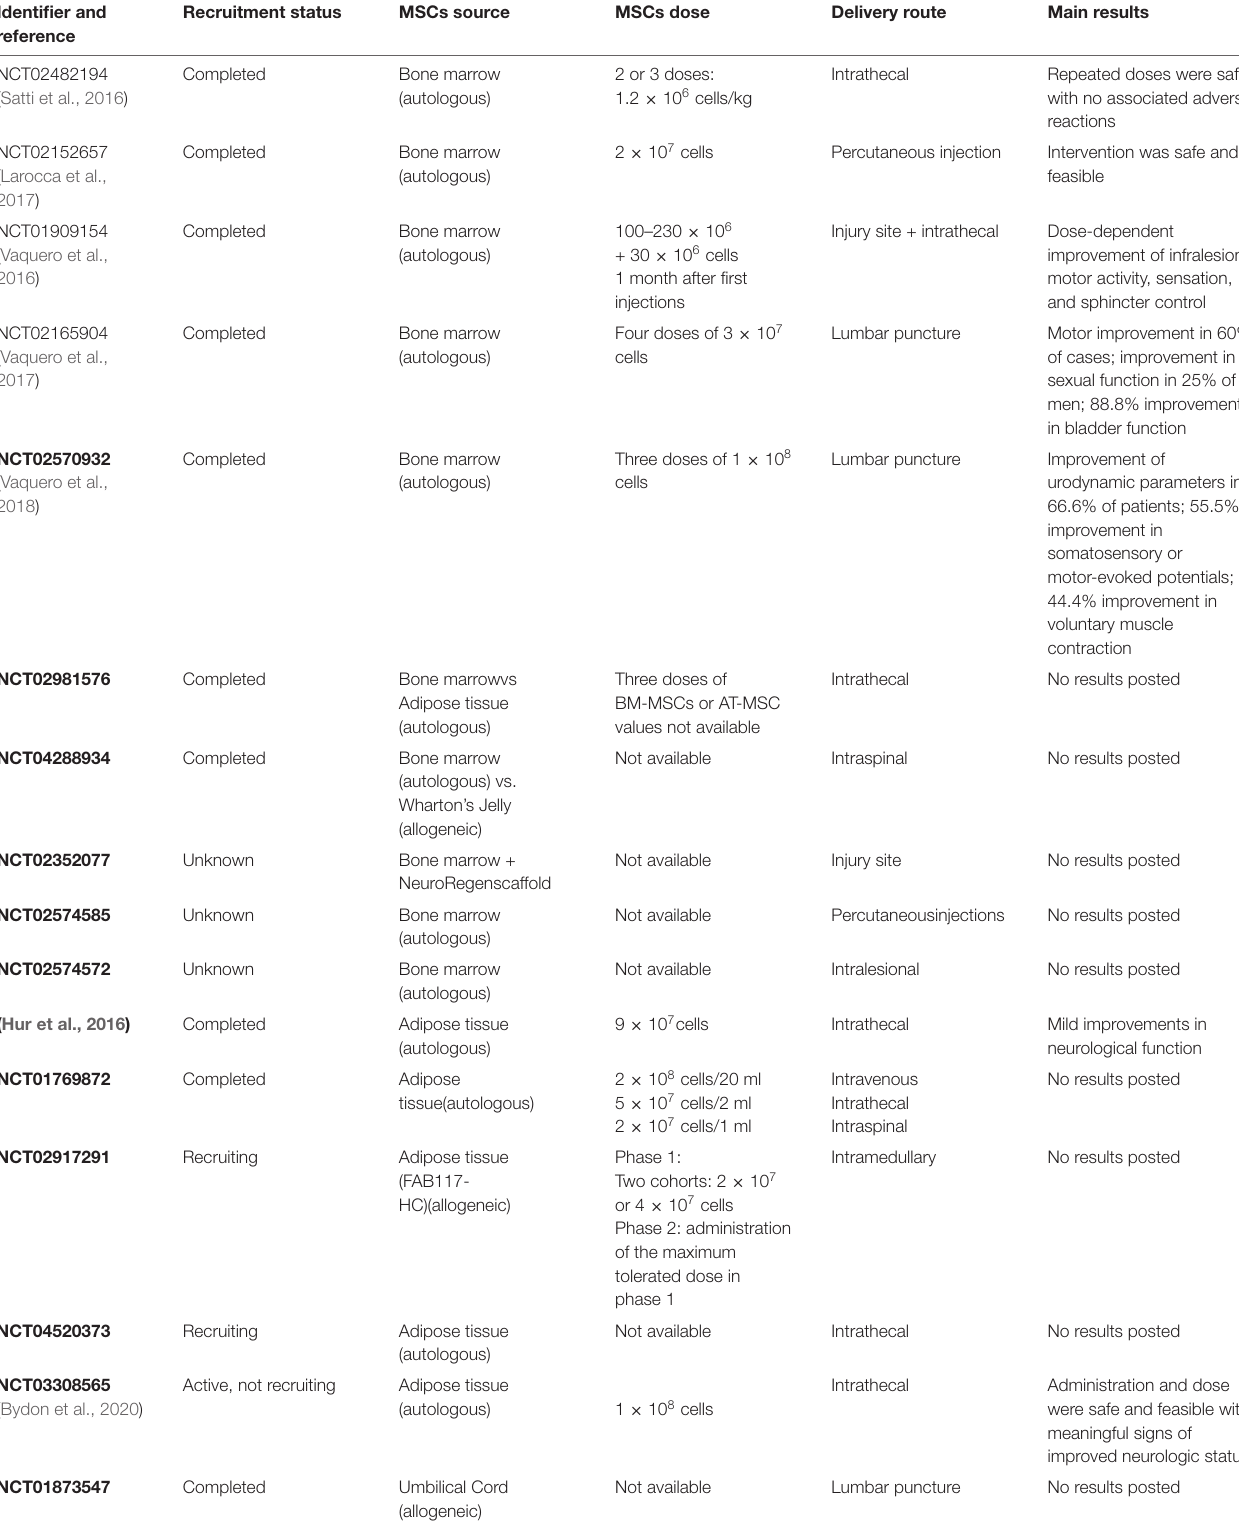
TABLE 4 | Clinical trials using mesenchymal stem/stromal cells in spinal cord